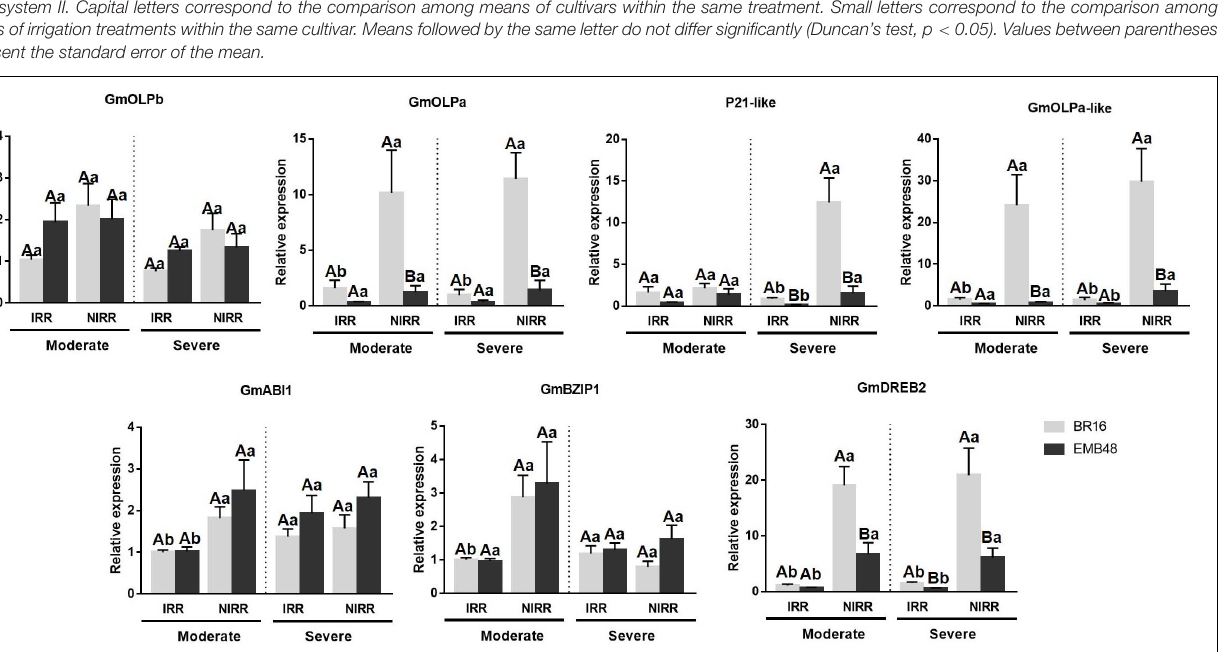
plants. A very low relative expression of P21 was